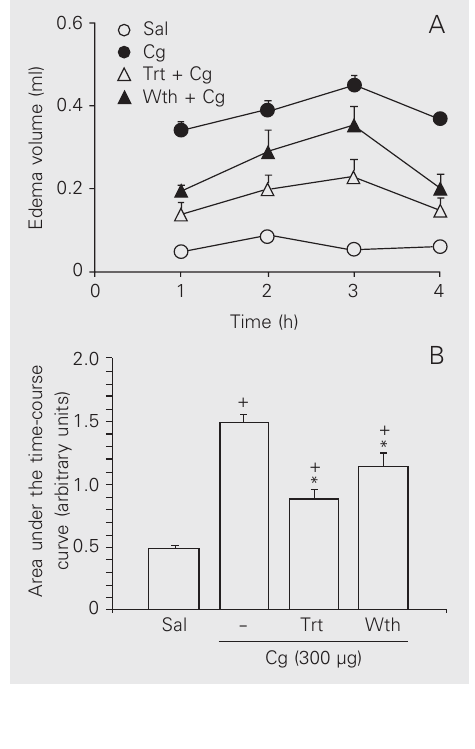
*Figure 2. Effect of ethanol inha- lation on paw edema induced by dextran. Rat paw edema was in- duced by intraplantar injection of dextran (Dx, 300 µg/0.1 ml) in animals exposed to ethanol va- por for a 10-day period (intoxi- cated or treated group, Trt) and animals pretreated with ethanol